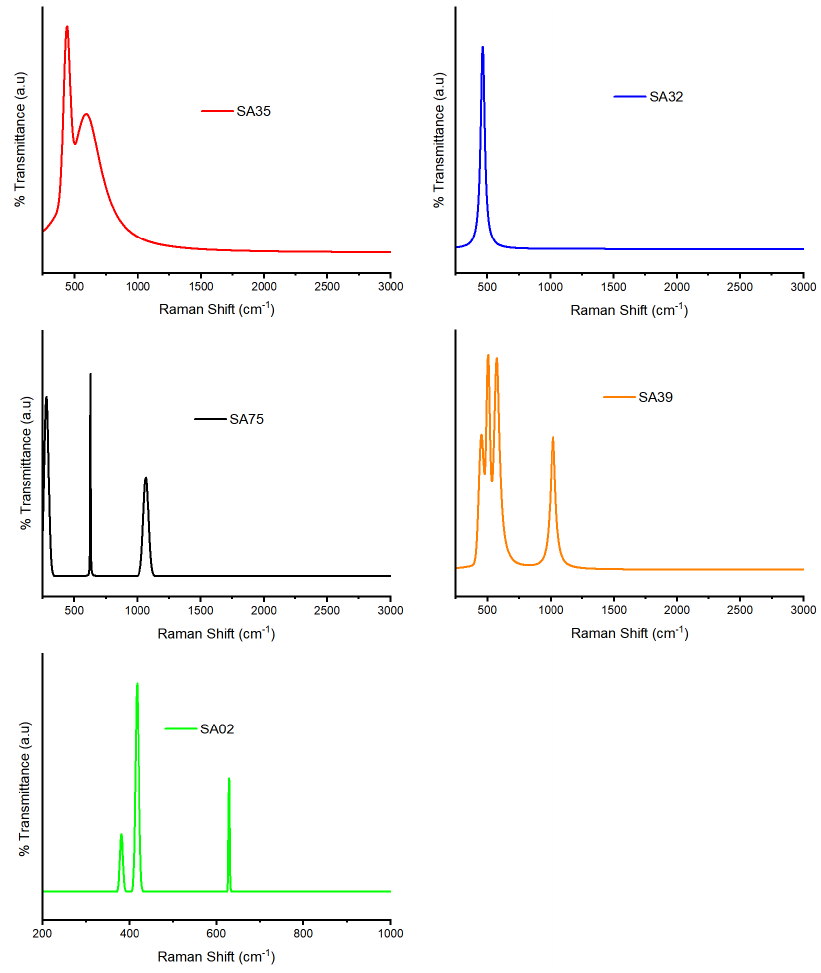
Figure 2. Crystal structure of UCHL3 S75E bound to Ub-PA . In all panels, UCHL3 S75E is in blue, Figure 6. Fresh Raman spectra of Ni-supported samples. UCHL3 WT is in orange, and Ub-PA and Ub-VME are in gray and white, respectively. ( A ) Overview Table 1. Comparison of the results of this work with those reported earlier for